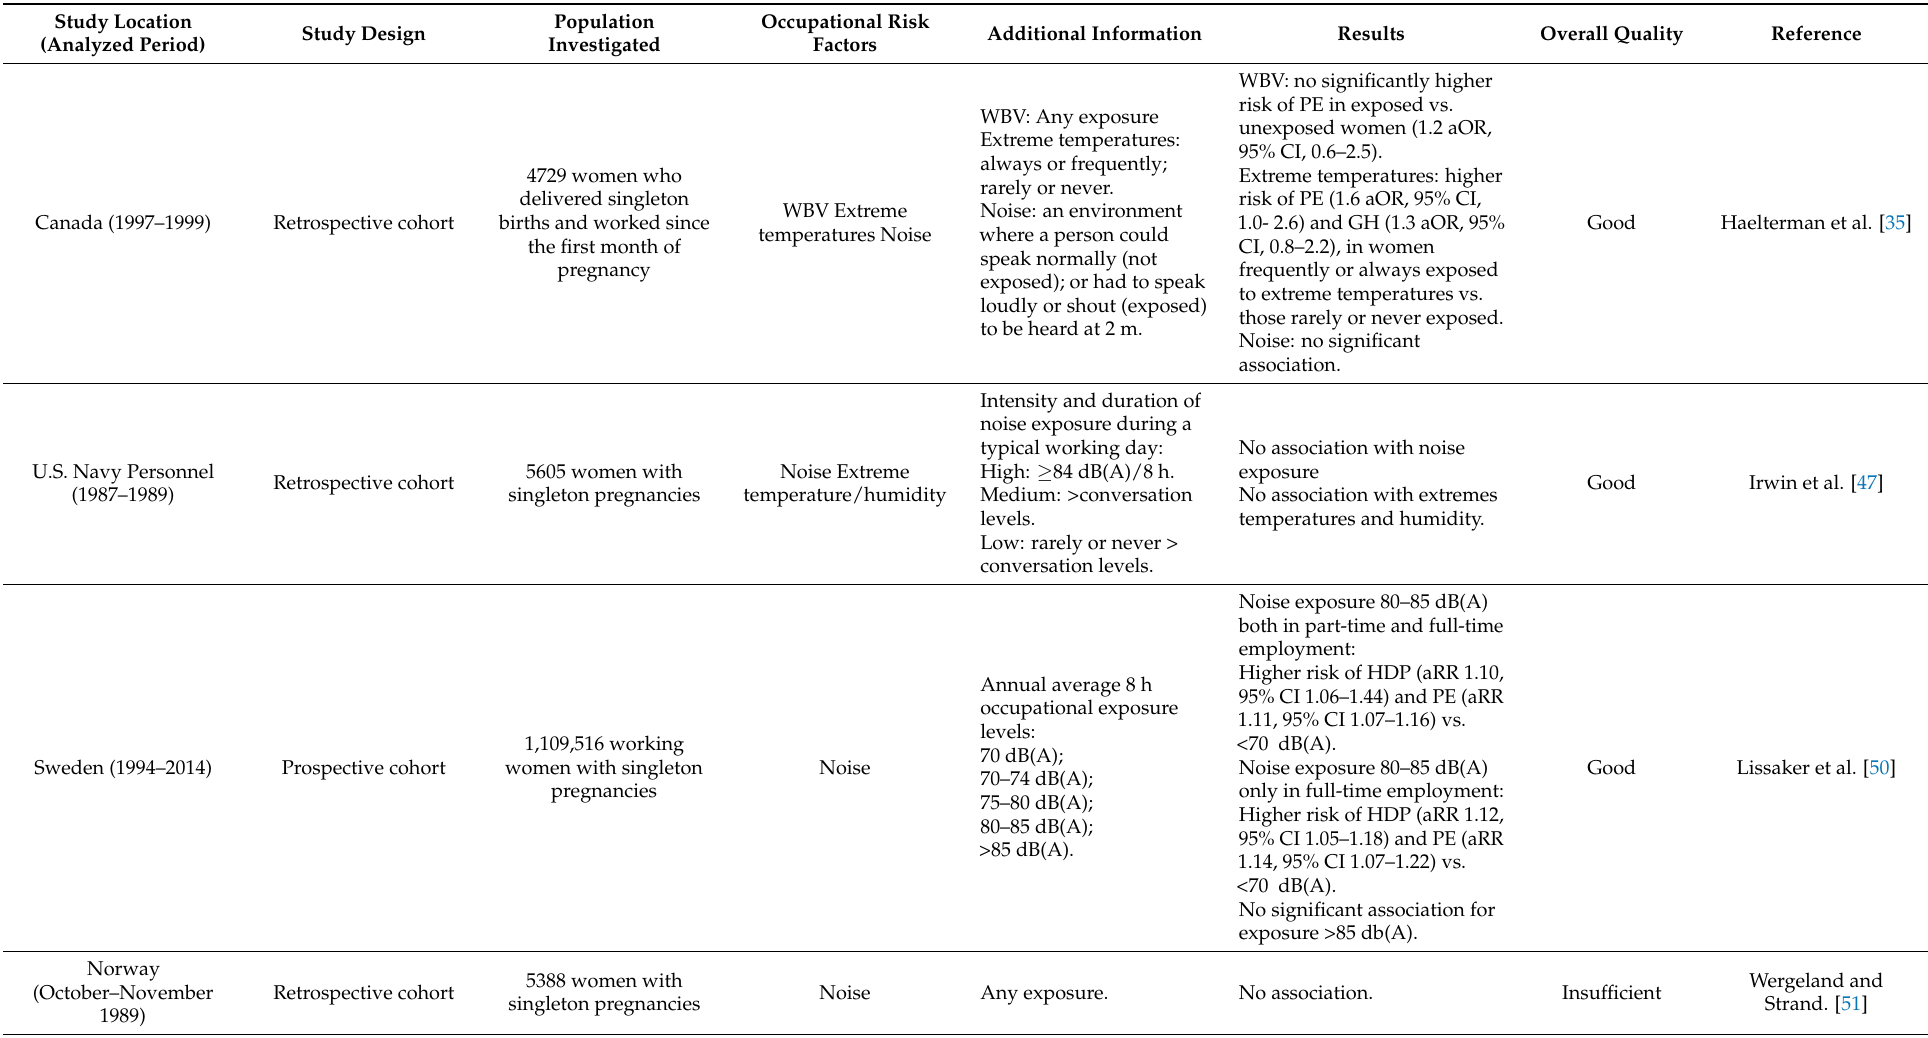
Table 3. Studies assessing the relationship between hypertensive disorders in pregnancy (HDP), including preeclampsia (PE) and gestational hypertension (GH), and exposure to physical risk